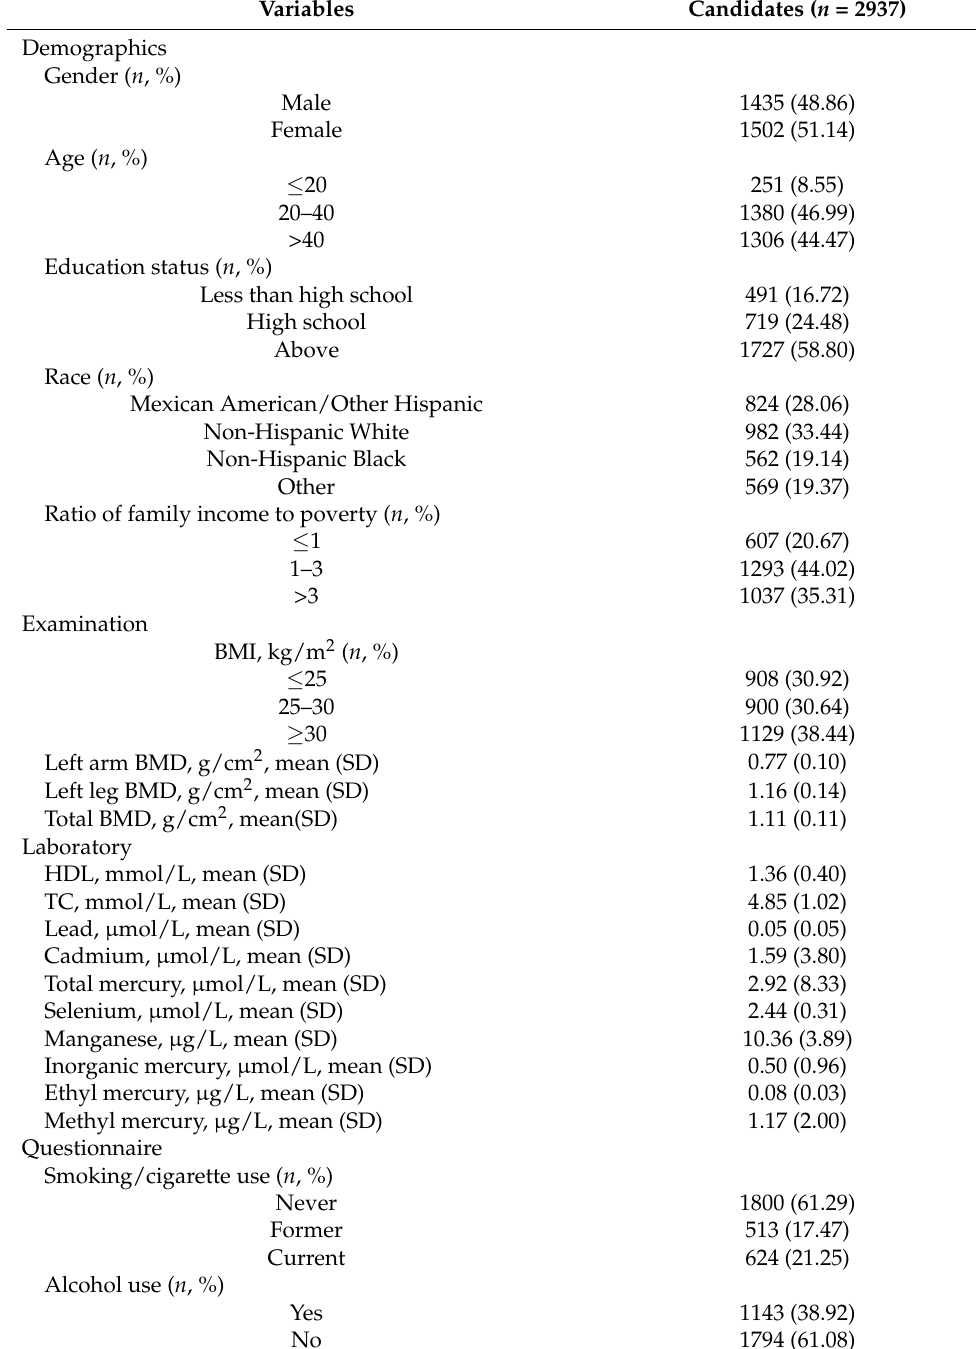
Table 1. Candidate variables and baseline characteristics in NHANES